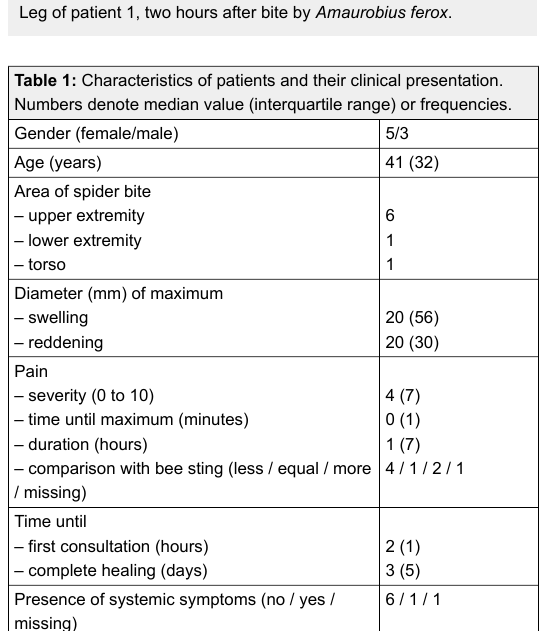
Leg of patient 1, two hours after bite by Amaurobius ferox .